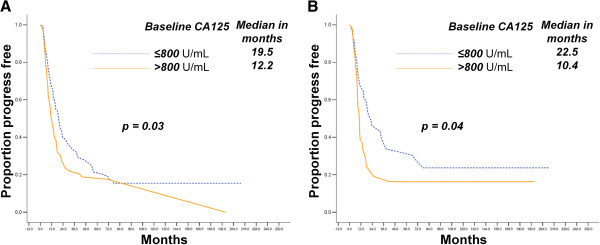
Baseline CA-125 level is associated with PFS in HG-SOCs from the MDACC (A) and JICR (B) groups.